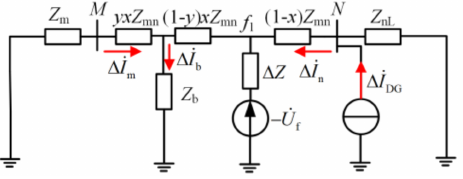
Figure 7. Composite sequence network of the positive-sequence fault component: the UBL is upstream of the fault point in case of an internal fault.